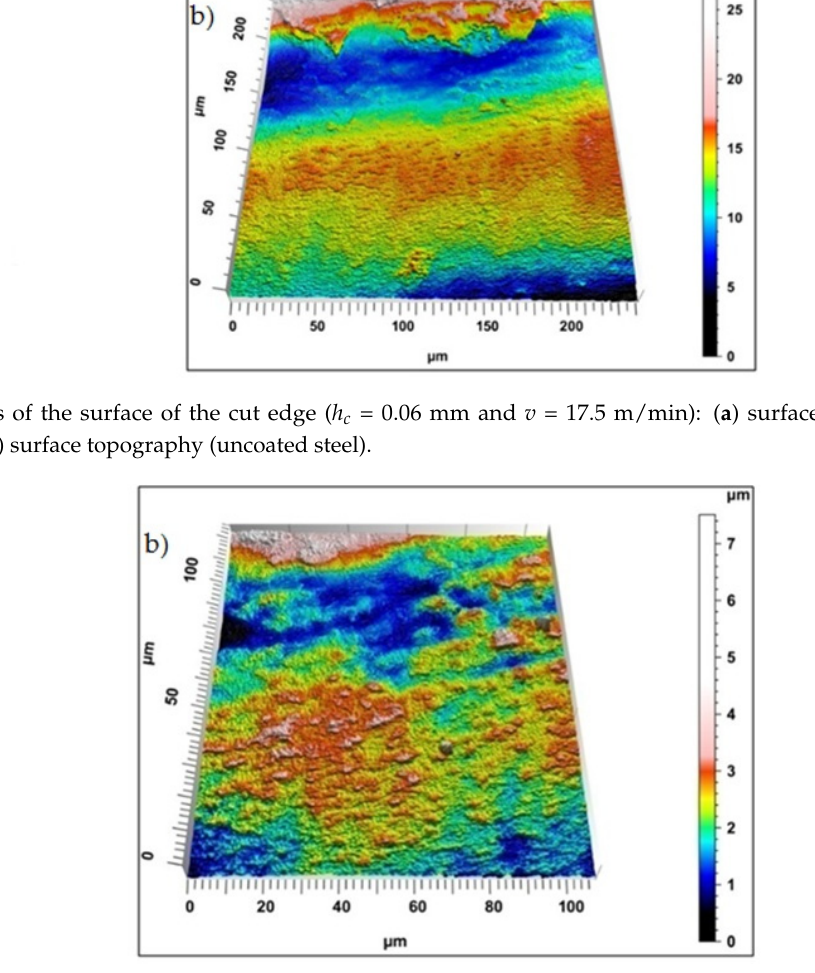
Figure 10. Views of the surface of the cut edge ( h c = 0.06 mm and v = 17.5 m/min): ( a ) surface photography, ( b ) surface topography (coated steel).